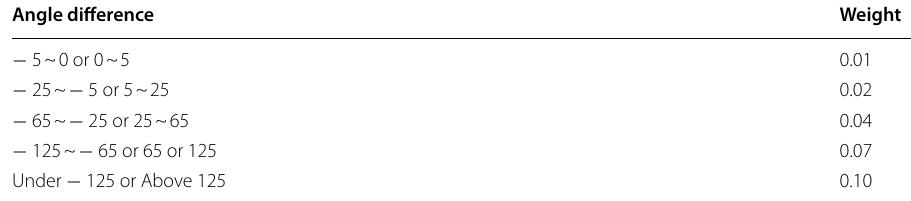
Table 2 Weight according to angle